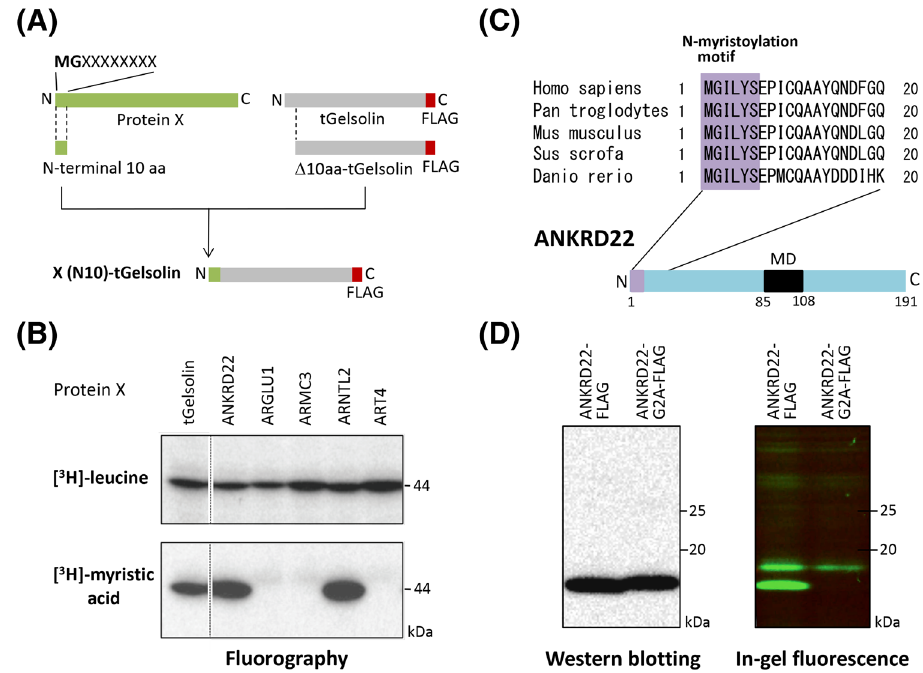
Figure 1. ANKRD22, a functionally unknown putative single-pass membrane protein, is N-myristoylated. Five candidate proteins (ANKRD22, ARGLU1, ARMC3, ARNTL2, and ART4) for novel human N-myristoylated proteins were selected from proteins listed in the UniProtKB/Swiss-Prot protein database, and their susceptibility to protein N-myristoylation was evaluated by in vitro and in vivo metabolic labeling. ( A ) Schematic representation of the generation of X(N10)-tGelsolin-FLAG with 10 N-terminal amino acids of the candidate protein X at its N-terminus. ( B ) Detection of protein N-myristoylation of X(N10)-tGelsolin-FLAGs by metabolic labeling in an insect cell-free protein synthesis system. X(N10)-tGelsolin-FLAGs were synthesized in the presence of [ 3 H]leucine or [ 3 H]myristic acid, and the labeled translation products were analyzed by SDS- PAGE and fluorography, as described in the “Methods”. A part of the fluorogram was cropped. The positions of the splices are indicated by vertical dashed lines. The uncropped raw image data for the fluorogram are shown in Supplementary Figure S7. ( C ) Structure of ANKRD22. Interspecies alignment of the N-terminal sequences of ANKRD22 is shown. N-myristoylation motifs are shown in purple in the N-terminal sequences. The predicted transmembrane domain is indicated as a black box. ( D ) Detection of protein N-myristoylation of ANKRD22 by metabolic labeling in transfected COS-1 cells. cDNA encoding ANKRD22-FLAG and ANKRD22-G2A- FLAG was transfected into COS-1 cells. The expression of proteins was evaluated by Western blotting using an anti-FLAG antibody. Protein N-myristoylation was evaluated by metabolic labeling with a myristic acid analog followed by click chemistry, as described in the “Methods”. The blot obtained by Western blotting was cropped. The raw image data for the full-length blot is shown in Supplementary Figure